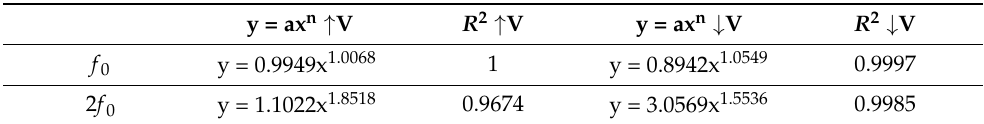
Figure 11. Variation of ( A ) f 0 and ( B ) 2 f 0 in absolute FFT with linear increase in electrical voltage. Polynomic fitting is included. Table 6. Polynomial fitting parameters of curves in Figure 11.